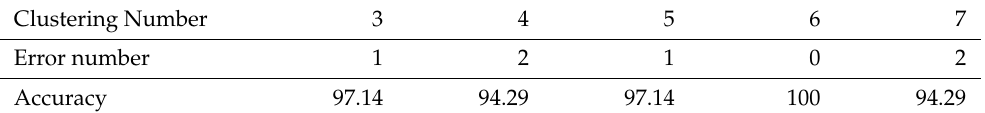
Table 2. The clustering accuracy corresponding to different clustering numbers.